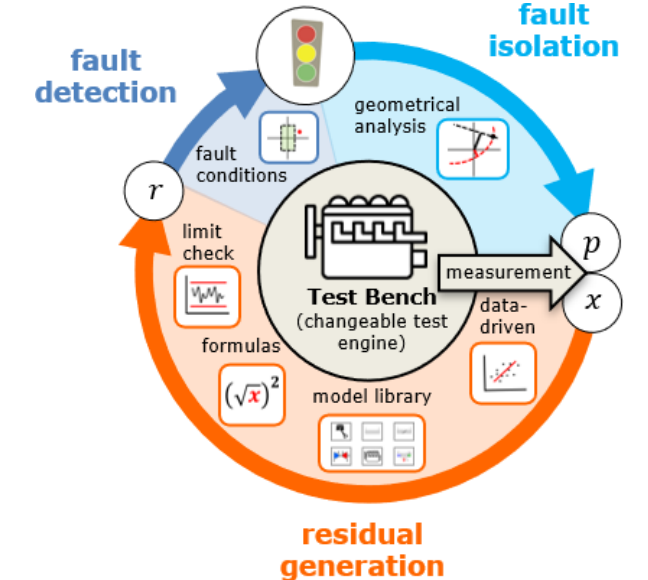
Figure 1. Scheme of the diagnostic